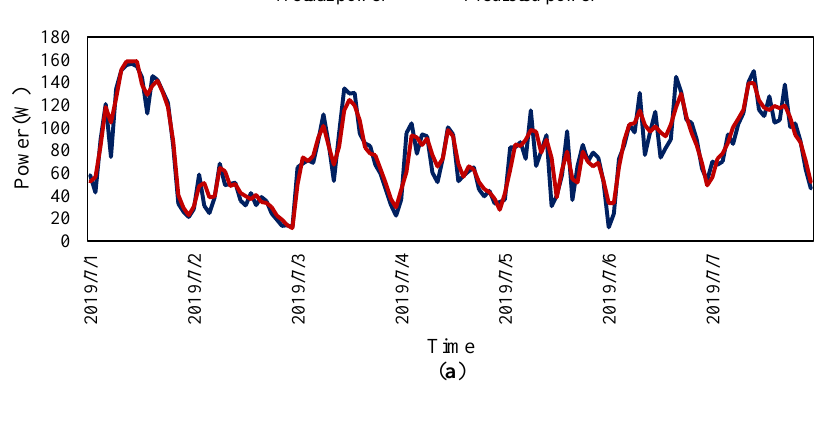
Figure 13. Forecasting and actual power diagram of deep learning models for one day. According to the results of the output power prediction, the EN-1 model has shown better performance. Figure 14 represents the output power forecasting of the LSTM en- semble model. As shown in Figure 14a, the graphs of actual and predicted output power during one week in summer are depicted. Figure 14b illustrates the actual and predicted output power during one week in winter. As we can see, there exists a good convergence of the predicted output power to the actual output power in different seasons. Therefore, this model is able to accurately predict the output power of the PV system.